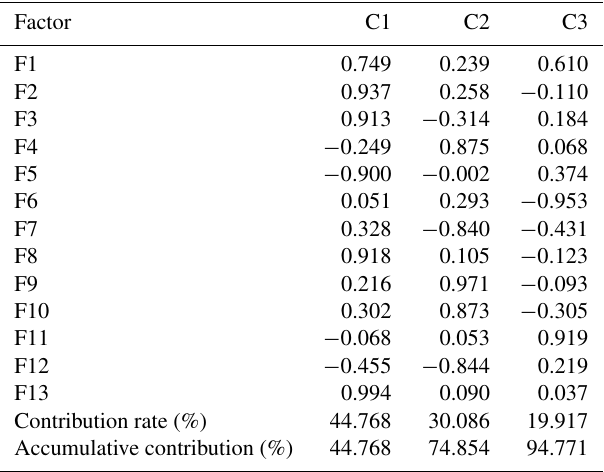
Table 9. The factor-loading matrix after rotation and contribution ratios for the fourth category.